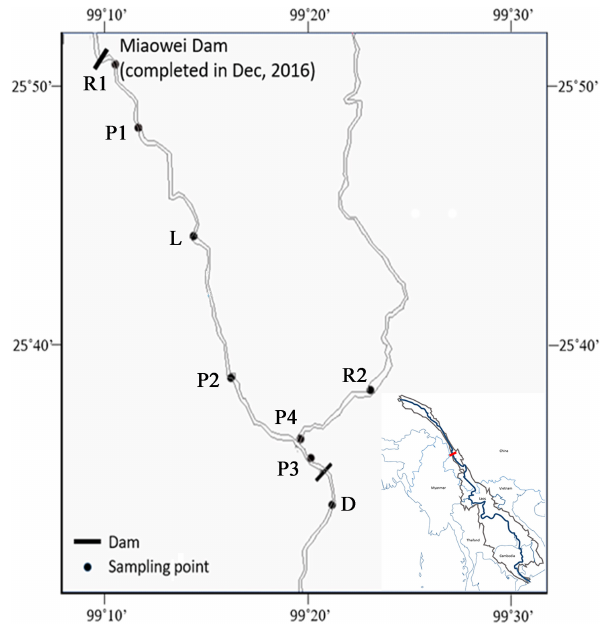
Figure 1. Sampling points in the Gongguoqiao Reservoir and its po- sition within the Mekong River Basin. Point R1 is downstream the Miaowei Dam which was completed in December 2016. Points P1, P2 and P3 were in the reservoir without flow velocity and point L was in the littoral zone. Point D was downstream of the reservoir. Points R2 and P4 were in the tributary the Bijiang River while all the other points were in the main stem of Mekong River (or Lancang